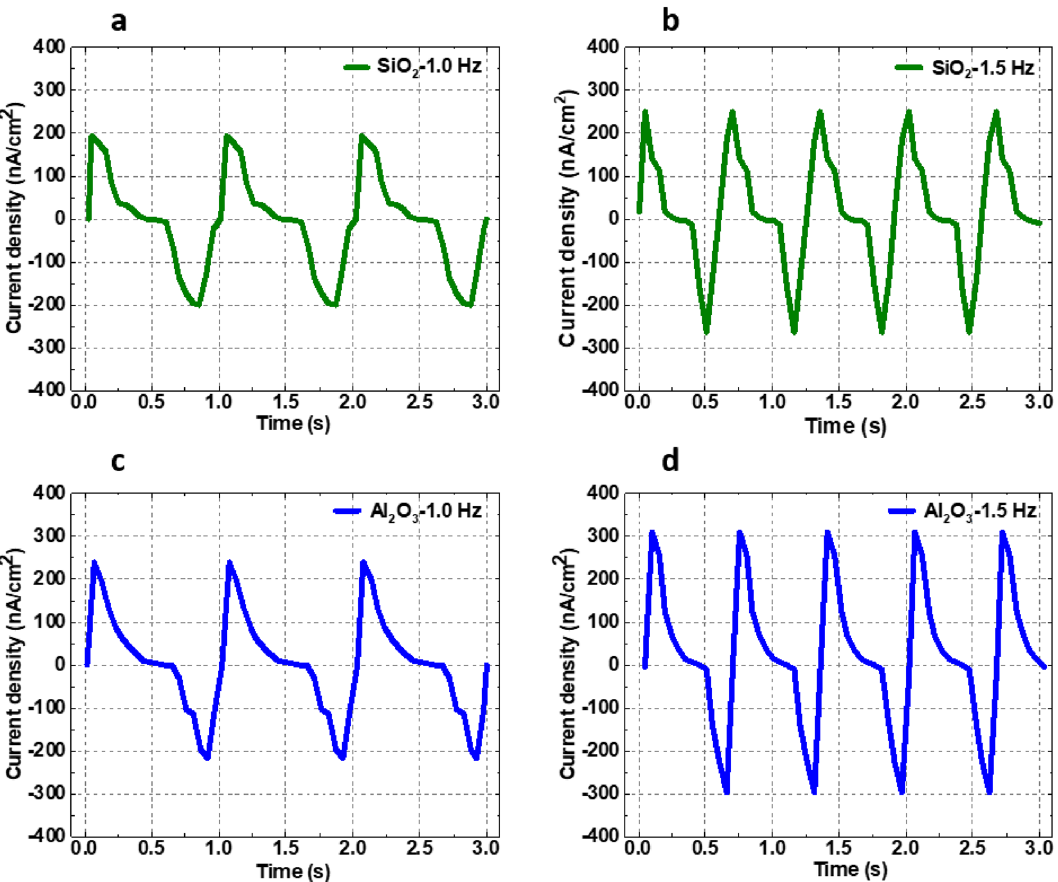
Figure 7. Representative AC peak-to-peak current density plots for the first three seconds of mechanical oscillation and using 1.0 M NaCl electrolyte for the following: ( a ) SiO 2 , 100 nm, 1 Hz; ( b ) SiO 2 , 100 nm, 1.5 Hz; ( c ) Al 2 O 3 , 100 nm, 1 Hz; and ( d ) Al 2 O 3 , 100 nm, 1.5 Hz. The positive and negative peaks are slightly different indicating charging and discharging characteristics of the